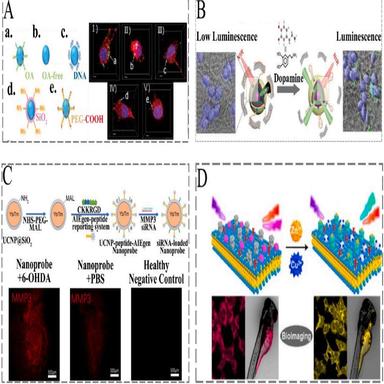
(A) Fluorescence images with different surface-modified UCNPs in motor neuron-like cells from ref.. Copyright 2017 The Royal Society of Chemistry. (B) Live cell upconversion luminescent images of DA and non-DA-neurons in live cell with Yb@Er@Yb UCNP from ref.. Copyright 2019 WILEY-VCH. (C) Detection of MMP3 activity in the PD mouse by the UCNP-peptide-AIEgen NP from ref.)]. Copyright 2021 American Chemical Society. (D) Distribution of Cu2+ and Zn2+ in zebrafish revea